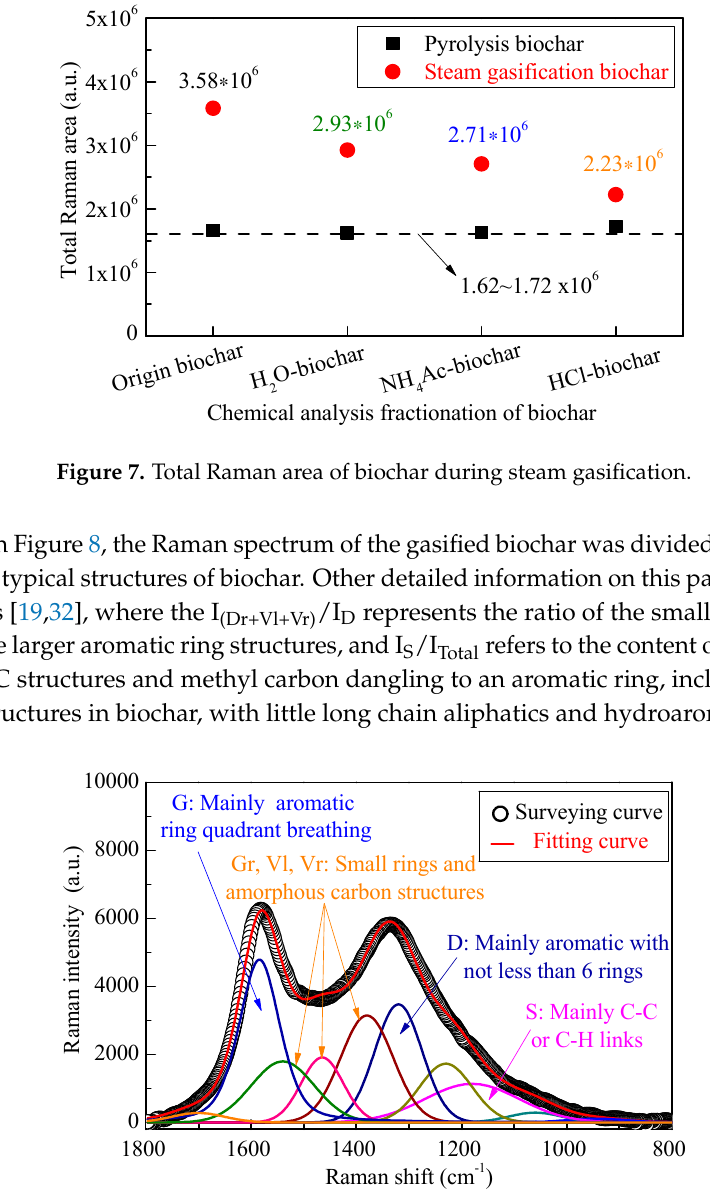
Figure 8. Curve fitting of the Raman spectrum of biochar.